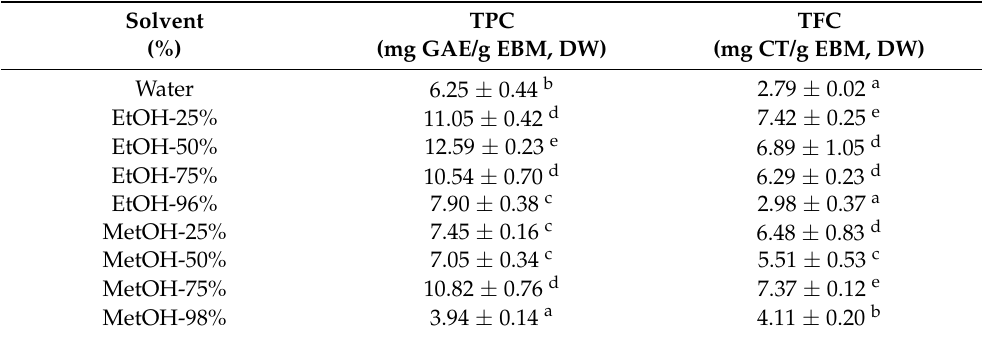
Table 2. Effect of solvent in the extraction of total polyphenols content (TPC) and total flavonoids content (TFC) of extracts of B. macrantha obtained at 50 ◦ C.